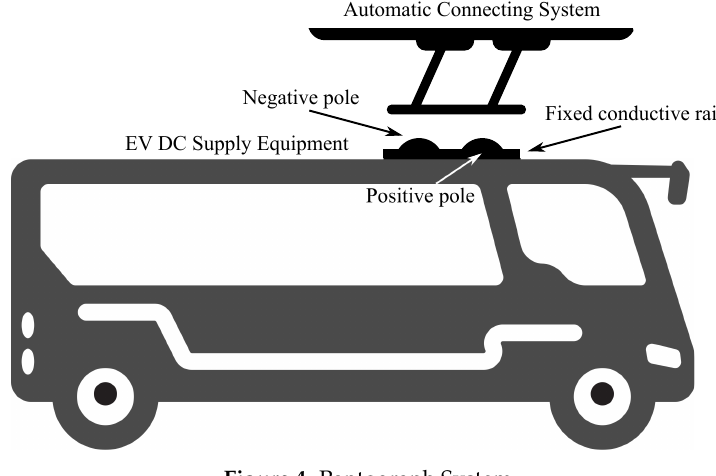
Figure 4. Pantograph